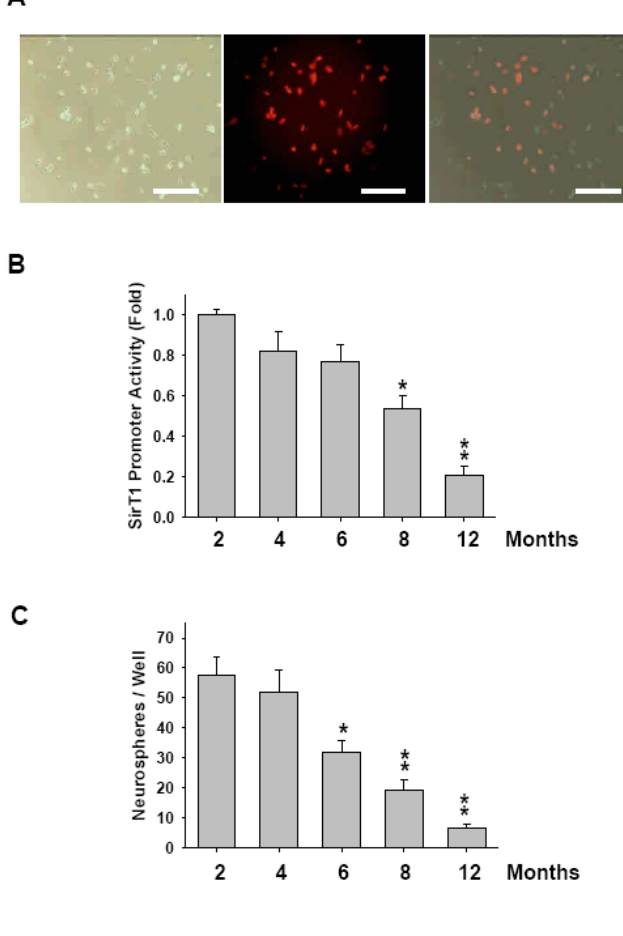
Figure 4. Expression activity of SirT1 in RSCs of different aged rats was evaluated by Sirt1 promotor. (A) RSCs from 2-month-old rats were transfected with pDsRed-SirT1p. Left: bright light. Middle: RFP. Right: merge. (Bar: 40 μm). (B) pGL2-SirT1p was transfected into rat RSCs. After harvesting the cells, lysates were assayed for luciferase activity. All relative luciferase activities were normalized with control Renilla luciferase expression. *p < 0.05; **p < 0.01 versus 2- and 4-month-old groups. (C) After 7 days of serum-free medium culture, the number of neurospheres was counted. Data shown here are the mean  SD of